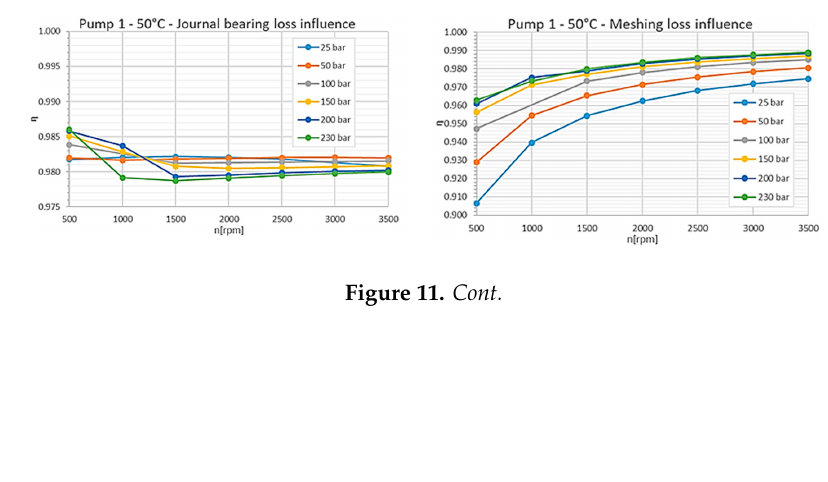
Figure 10. Calculated mechanical efficiency for pump 1 at 30 °C considering one type of loss at a time.